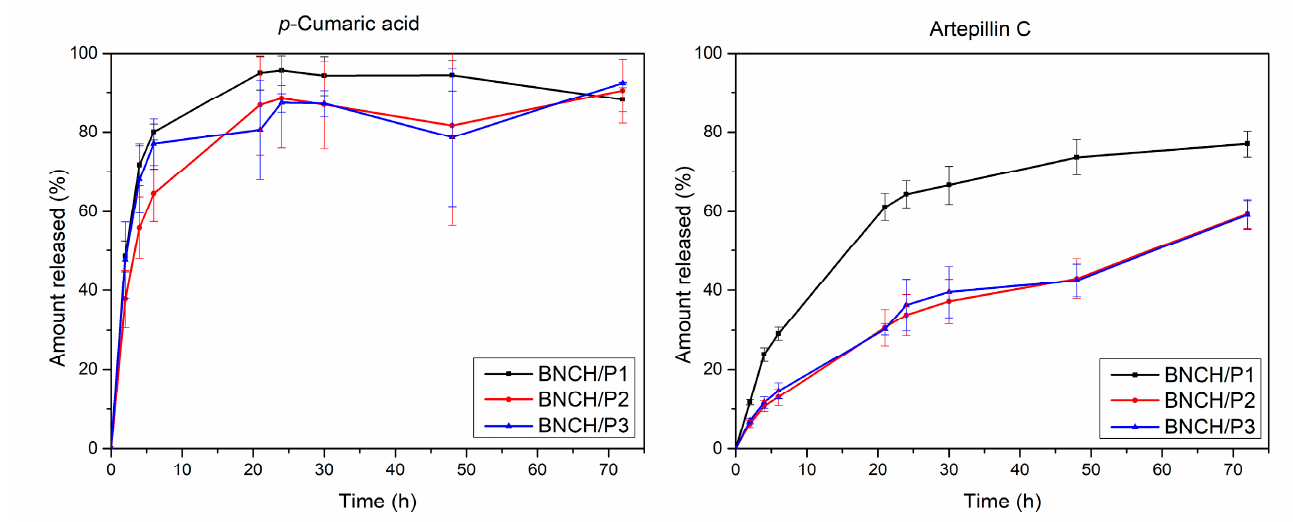
Figure 4. Release profiles of p -coumaric acid ( left ) and artepillin C ( right ) as percentage release over time.